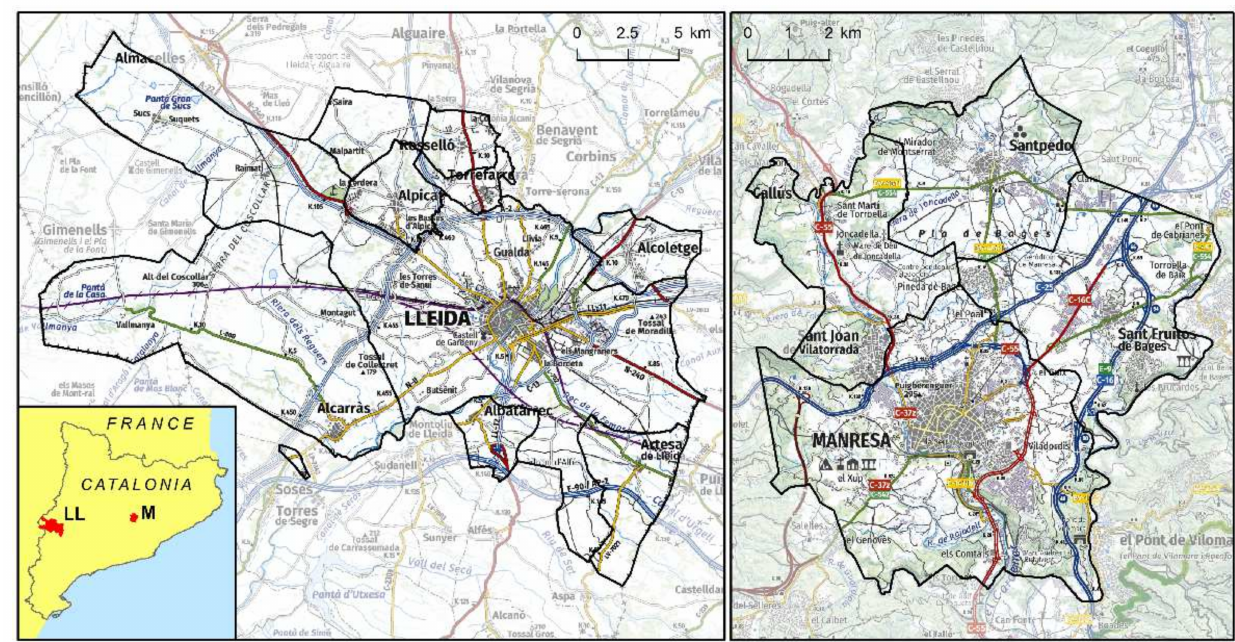
Figure 2. Urban areas and municipalities of Lleida and Manresa. Own elaboration based on Institut Cartogr à fic i Geol ò gic de Catalunya [36].